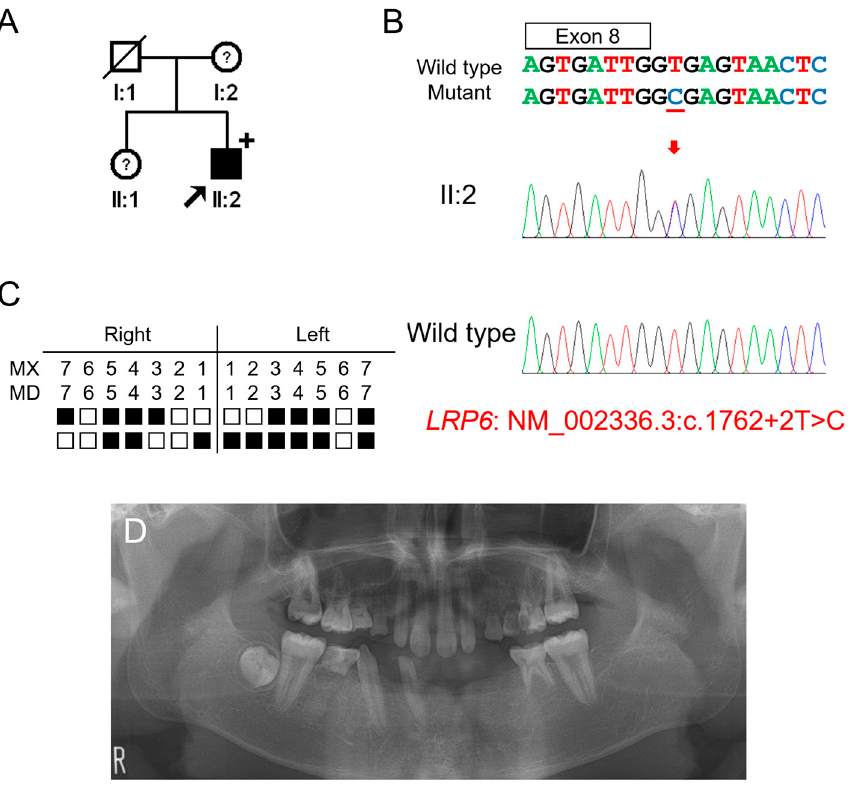
Figure 2. Pedigree, chromatograms and panoramic radiographs of family 2. ( A ) Pedigree of family 2. Black symbols indicate affected individuals, and the proband is indicated by a black arrow. Plus sign above the symbol indicates participating individuals. Symbols with a question mark inside indicate individuals whose phenotypes are not confirmed. ( B ) Sequencing chromatograms of the proband of family 2. Wild-type and mutant nucleotide sequences are shown above the chromatograms. Exon is indicated by a box above the nucleotide sequences. Nucleotide affected by the mutation is underlined. The location of the mutation is indicated with a red arrow. Individual identifications are indicated on the left side of each chromatogram. ( C ) Summary chart of the missing teeth of the proband. Black box indicates a missing tooth. Tooth number is shown above the boxes (MX: maxilla, MN: mandible). ( D ) Panoramic radiograph of the proband at age 14 years 5 months shows multiple missing teeth. First molars exhibit taurodontism.